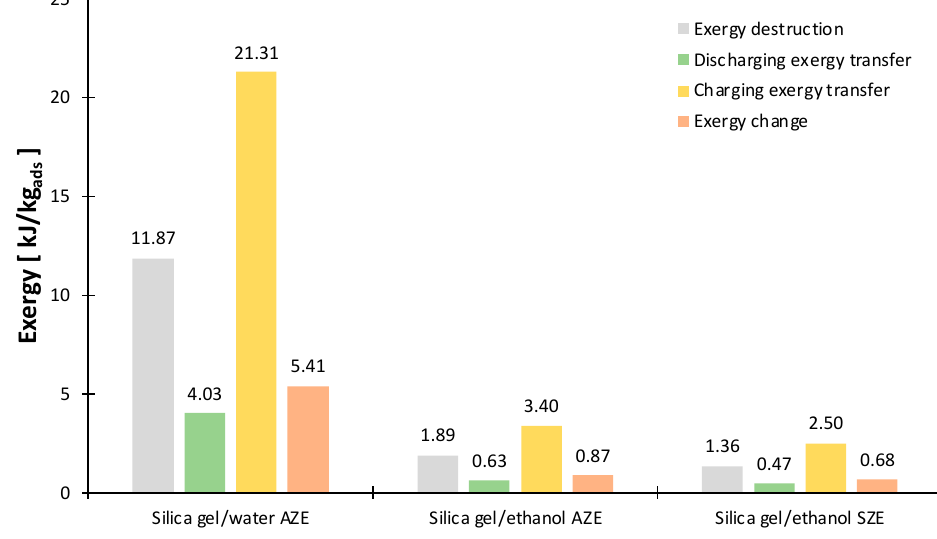
Figure 9. Breakdown of exergy destruction during heat charging/discharging cycle.